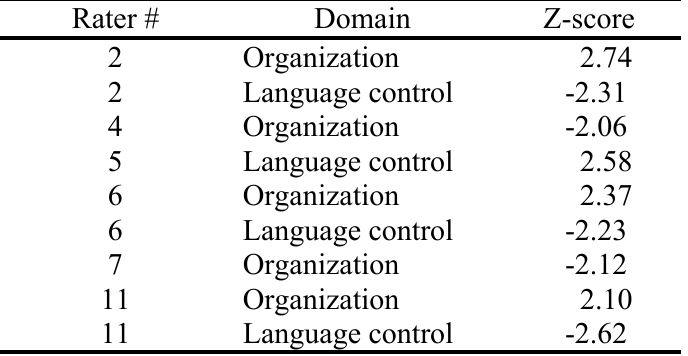
Significantly Biased Rater-Domain Interactions